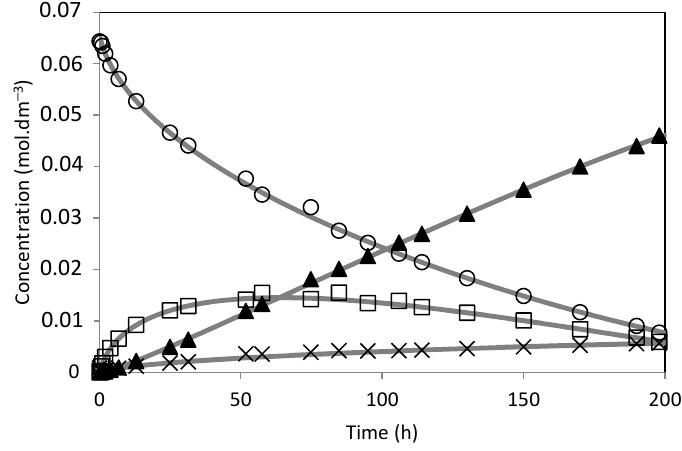
Figure 14. Camphene hydration over SBA-15-SO 3 H catalyst. ( ) Camphene; ( ) Camphene hy- drate; ( ) Isoborneol; ( × ) Others. The lines represent the model fitted to the experimental points.